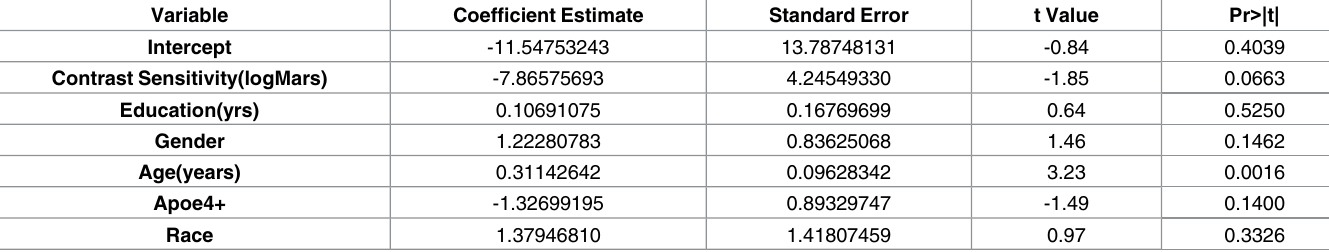
Table 4. Regression Analysis of Contrast Sensitivity Measure with Road Test Total Error